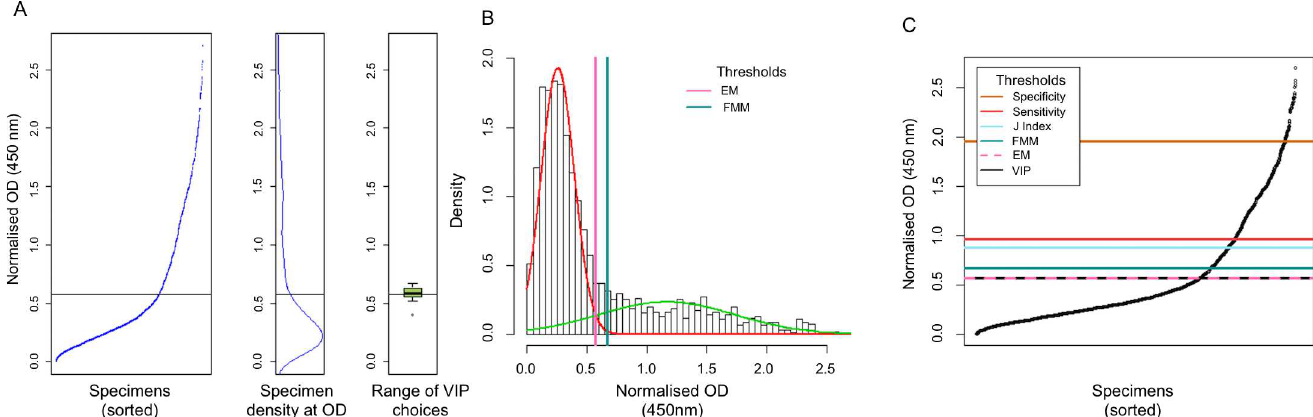
Fig 4. Threshold values for Gambian (all ages) data. Panel A shows the thresholdas determinedby visual inflectionpoint analysisby 12 volunteer individuals, as detailed above in Fig 2. Panel B shows the thresholdsset by the finite mixture model and expectation-maximisation algorithm, as describedin Fig 2. Panel C compares the threshold specifications by four different methods. Scatterplots show the normalised and sorted OD 450 values with horizontallines markingthe thresholds specifiedby VIP (OD 450 = 0.570), EM (OD 450 = 0.570), FMM (OD 450 = 0.672), ROC curve maximising Youden’sJ-index (OD 450 = 0.870), ROC curve with sensitivity > 80% (OD 450 = 0.968) and ROC curve with specificity > 98% (OD 450 = 1.951). Note that the thresholds set by VIP and EM are identical(0.570 OD 450 ) and overlap on the graph.